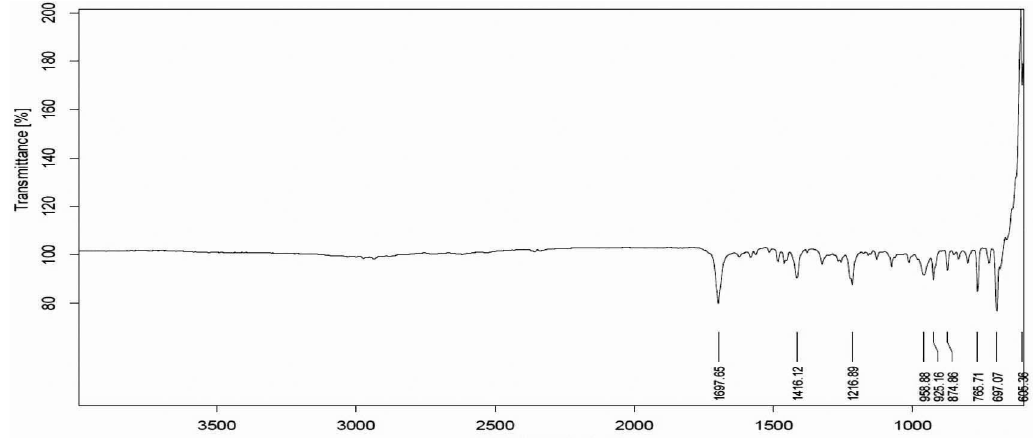
FIGURE 2 - FTIR spectrum of the tablet mixture (F9) containing flurbiprofen before compression.